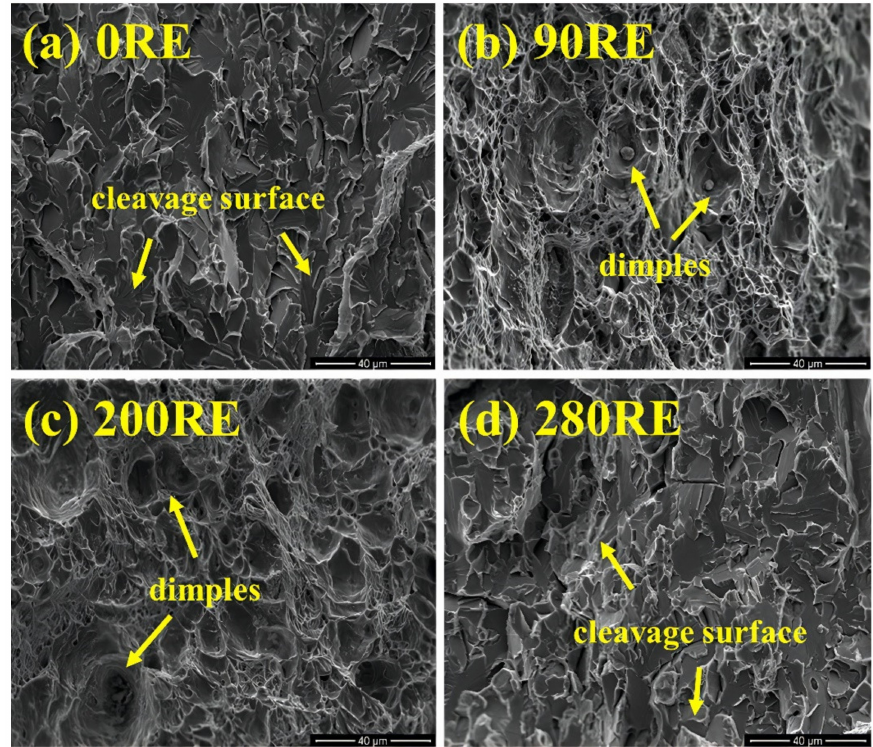
Figure 13. Fracture morphology of impact specimens with different yttrium-based rare earth contents